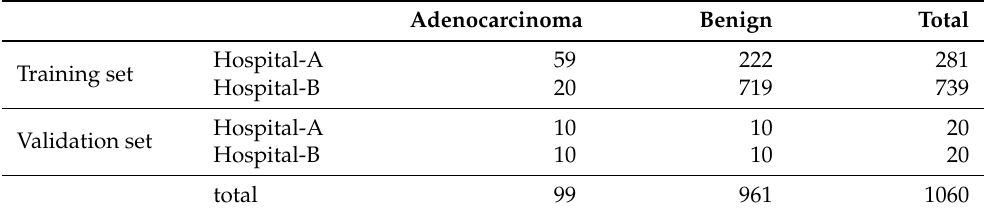
Table 2. Distribution of whole-slide images (WSIs) in the transuretheral resection of the prostate (TUR-P), public dataset (TCGA), and needle biopsy test sets obtained from three hospitals (A–C). Adenocarcinoma Benign Total Hospital-A–B 70 430 500 TUR-P Hospital-A 40 160